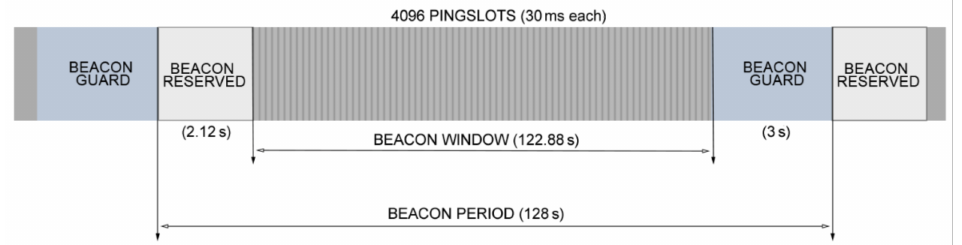
Figure 1. Class B beacon window temporal